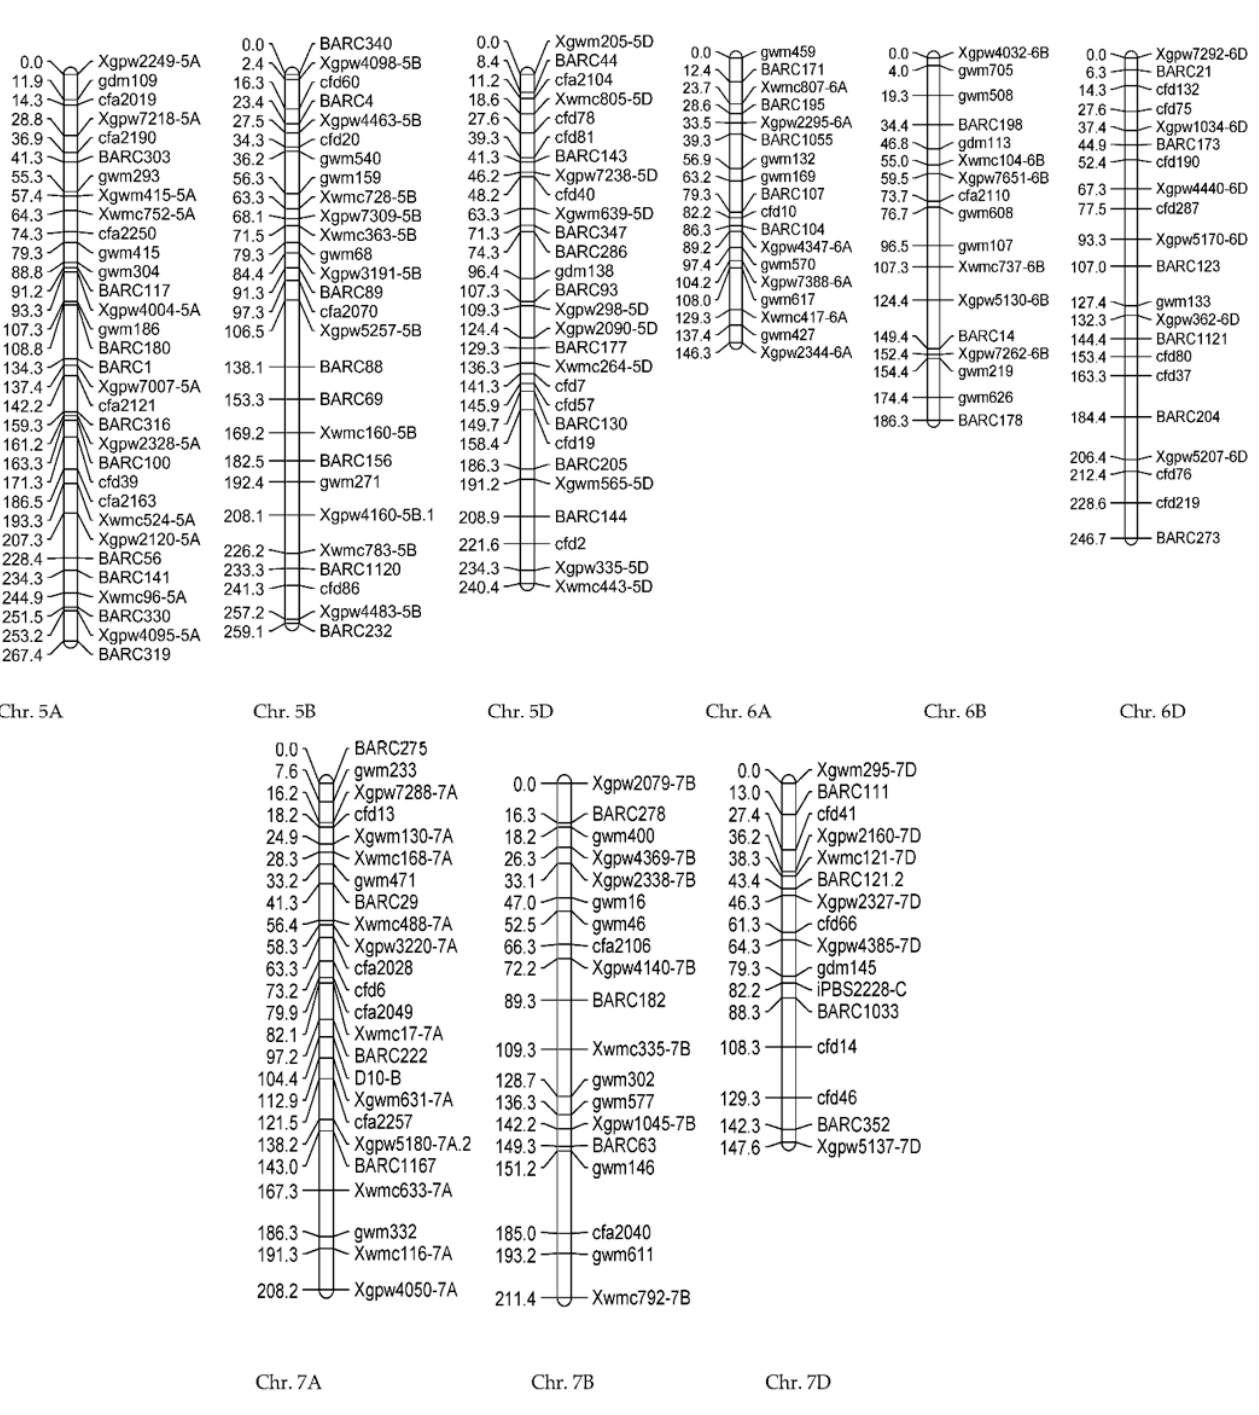
Figure 6. SSR linkage map developed using F8 wheat lines resulting from Gonbad × Zagros. In the Zagros and Gonbad populations, different QTLs were identified for two years.